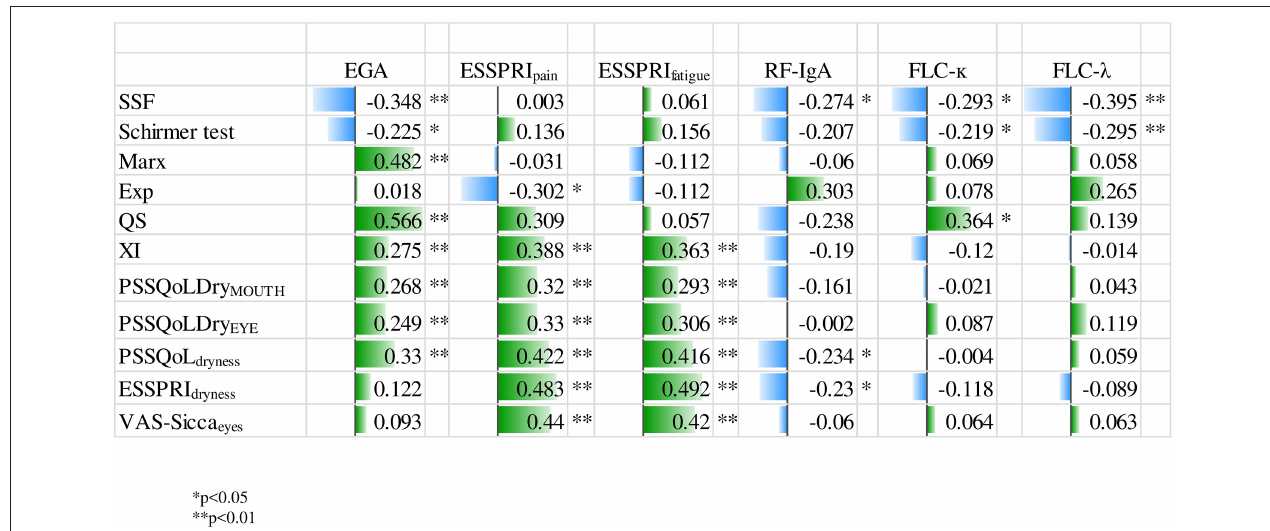
FIGURE 1 | Relationship between dryness and clinical parameters. EGA, evaluators global assessment; ESSPRI, EULAR Sjögren syndrome patient reported index; Exp, expressibility; FLC- κ , free light chain kappa; FLC- λ , free light chain lambda; Marx, Marx line; PSS-QoL, primary sjögren syndrome quality of life questionnaire; QS, quality of meibomian gland secretion; RF-IgA, rheumatoid factor immunoglobin-A; SSF, stimulated salivary flow; VAS, visual analog scale; XI, xerostomia index.